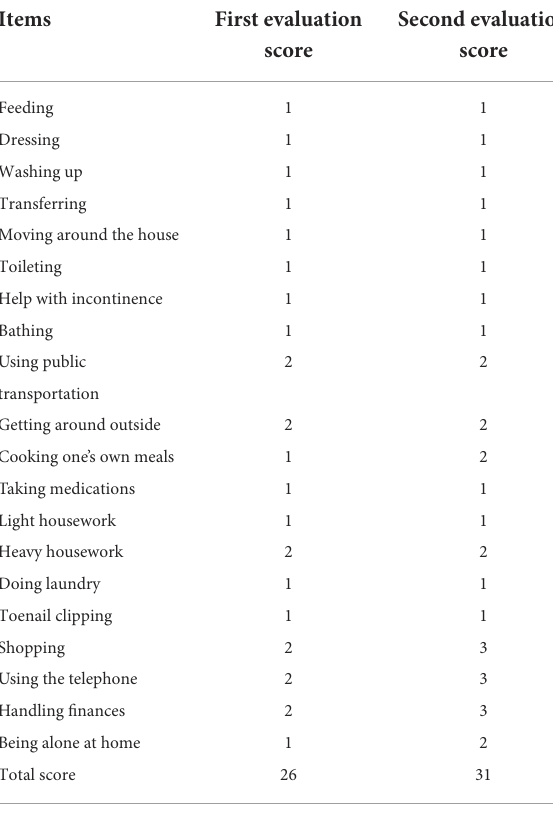
TABLE 1 Results of ADL evaluating at age 71 and 73. TABLE 2 Results of ABC (Aphasia Battery of Chinese) evaluating at age